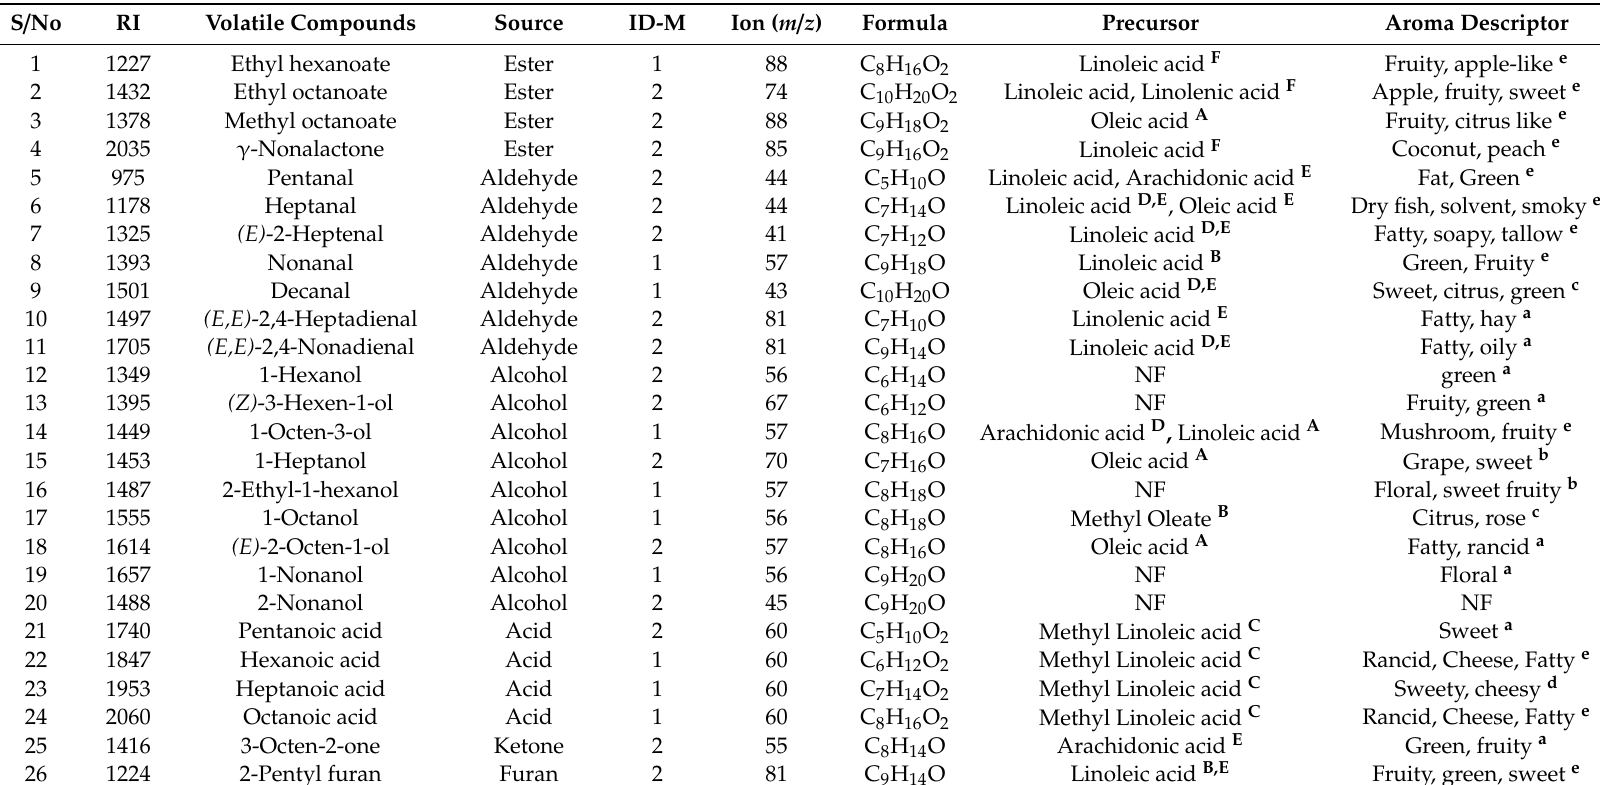
Table 2. The description of identified UFAO-derived compounds in Thompson seedless